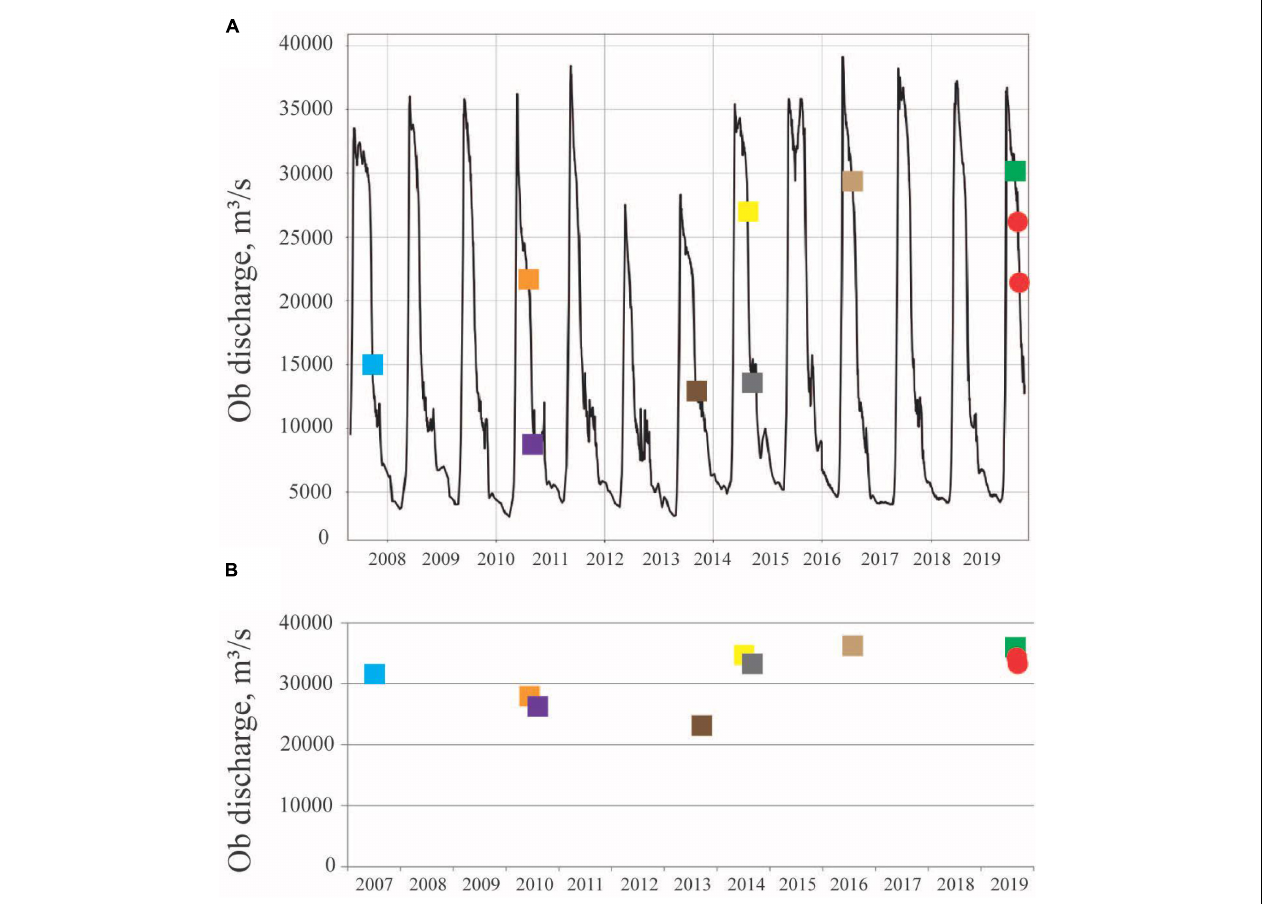
FIGURE 5 | Discharge of the Ob River to the Gulf of Ob in 2007–2019 (A) and average discharge from the beginning of summer freshet till the periods of oceanographic field surveys (B) . Colored squares and circles in panel (A) indicate periods of the oceanographic field surveys as shown in Figure 2 . Note that the two surveys in August 2019 are indicated by two red circles.